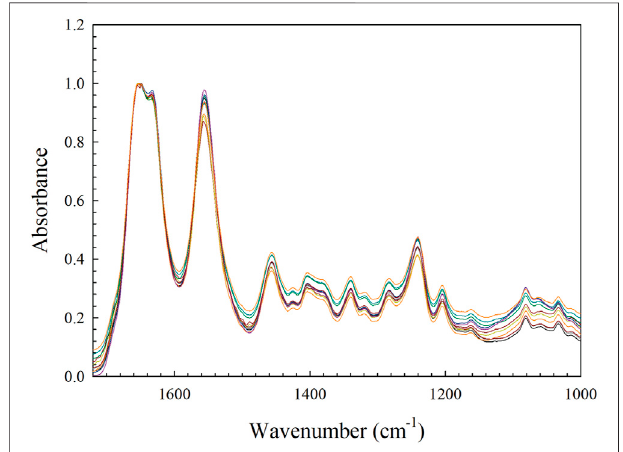
FIGURE 6 | A sample of 11 normalized FTIR spectra of untreated collagen gels, superimposed to demonstrate reproducibility.